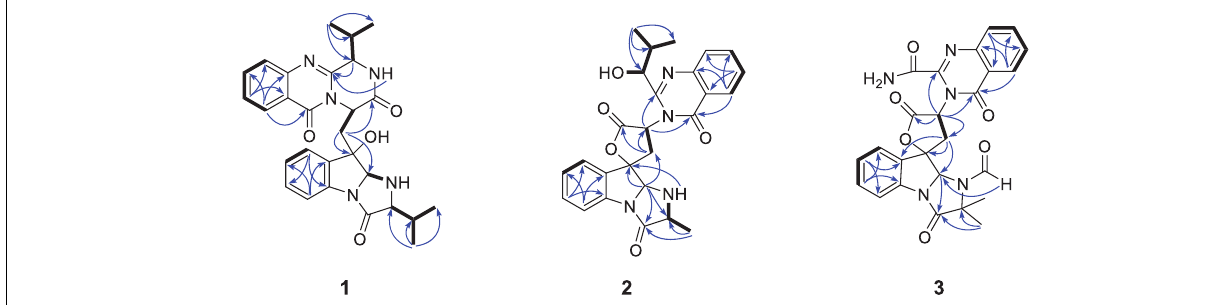
FIGURE 2 | The key HMBC (arrows) and COSY (bold) correlations for compounds 1 – 3 .